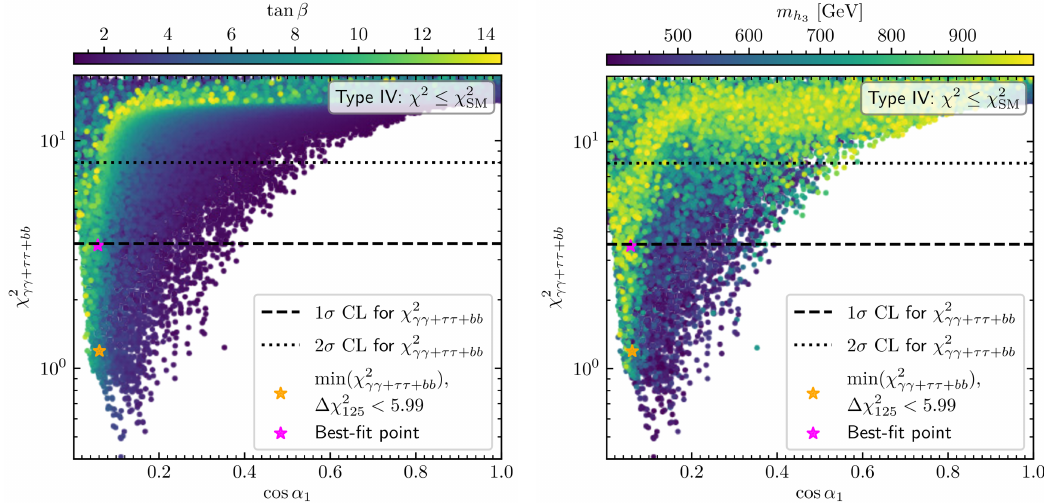
Figure 5 . χ 2 in dependence of cos α 1 . The color coding indicates the values of tan β (left) γγ + ττ + bb and m h (right). The magenta and orange stars are defined as in figure 3. The horizontal dashed 3 and dotted lines indicate the 1 σ and the 2 σ regions,